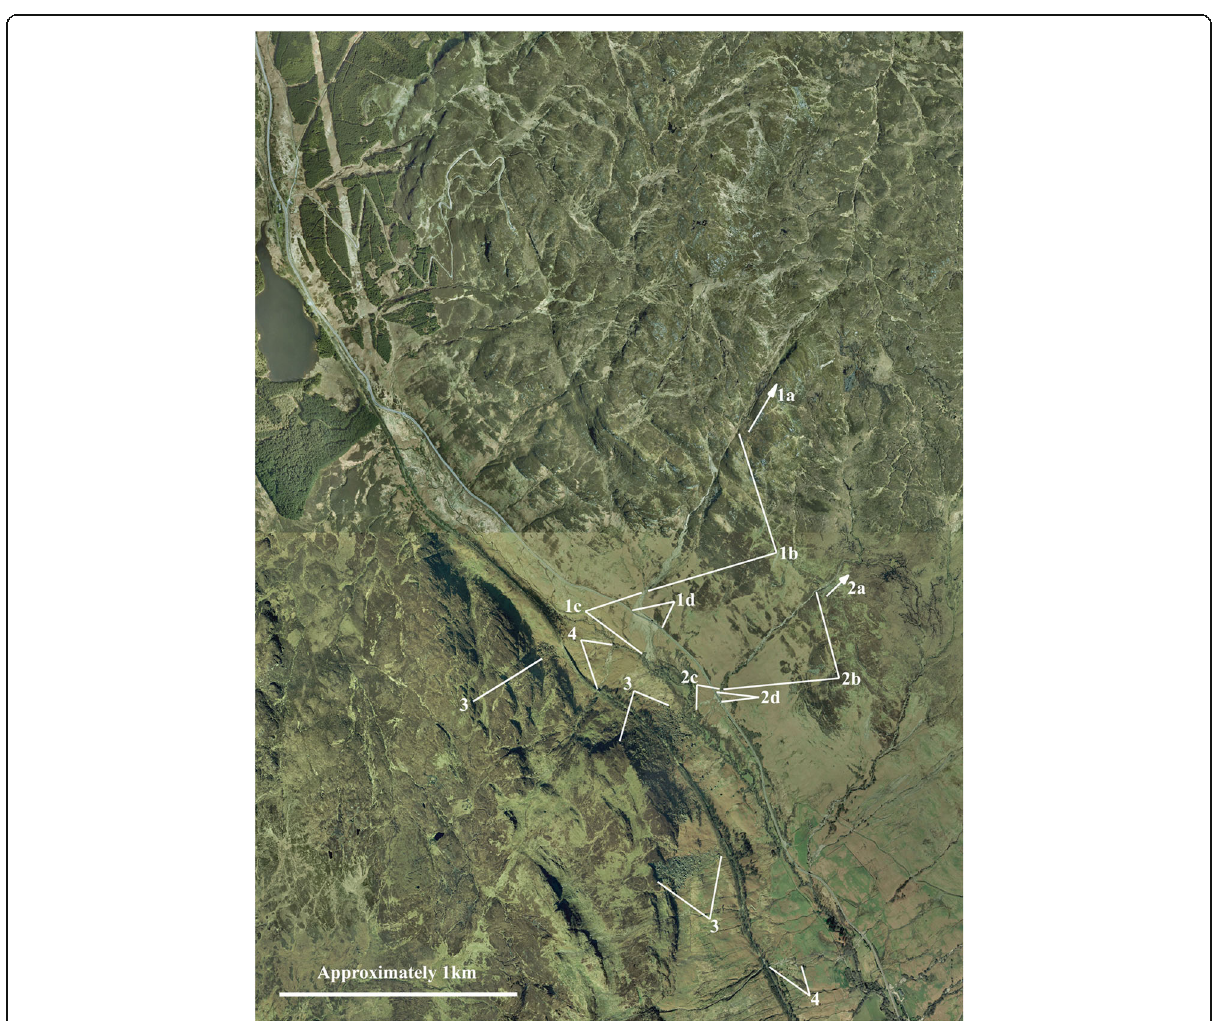
Fig. 8 Aerial photograph showing a large part of Glen Ogle. The image was made by stitching adjacent 1 km by 1 km tiles before cropping to give approximately 4 km (vertical) by 3 km (horizontal) coverage; north is to the top. (From Winter et al. 2009.). Key: 1. North debris flow: (a) potential source areas, (b) debris track, (c) runout/ debris fan and (d) subsequent carriageway repair. 2. South debris flow: (a) potential source areas, (b) debris track, (c) runout/ debris fan and (d) subsequent carriageway repair. 3. Historic rock falls. 4. Other debris flows assumed to have occurred in August 2004. Base aerial photography reproduced by permission of Ordnance Survey, on behalf of HMSO,© Crown copyright and database rights, 2020. All rights reserved. Ordnance Survey Licence number